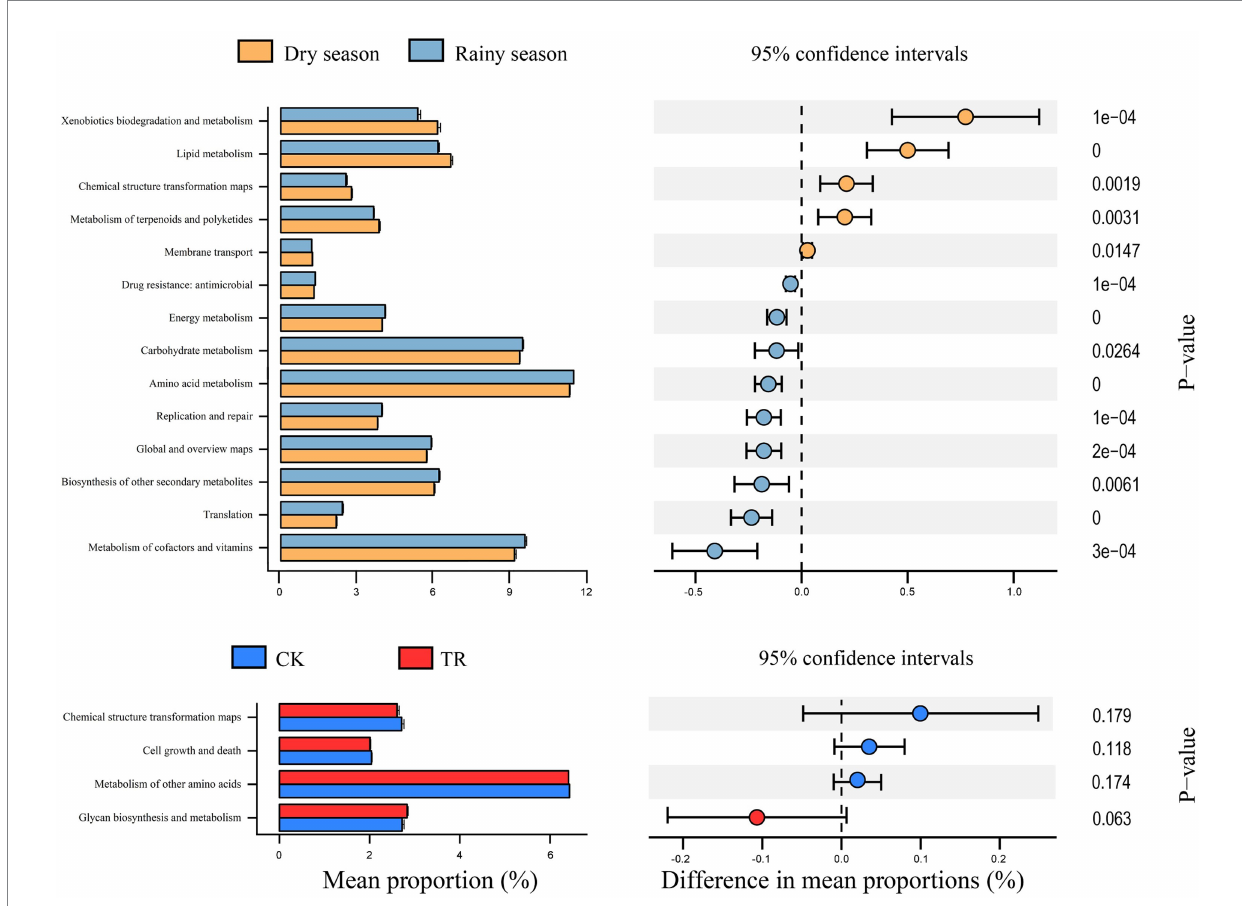
FIGURE 7 STAMP analysis of bacterial function prediction (hierarchy level 2). In the figure, Y-axis is the pathway predicted by function. Column length is the average relative abundance of the pathway in each sample group. CK: control; TR: throughfall reduction